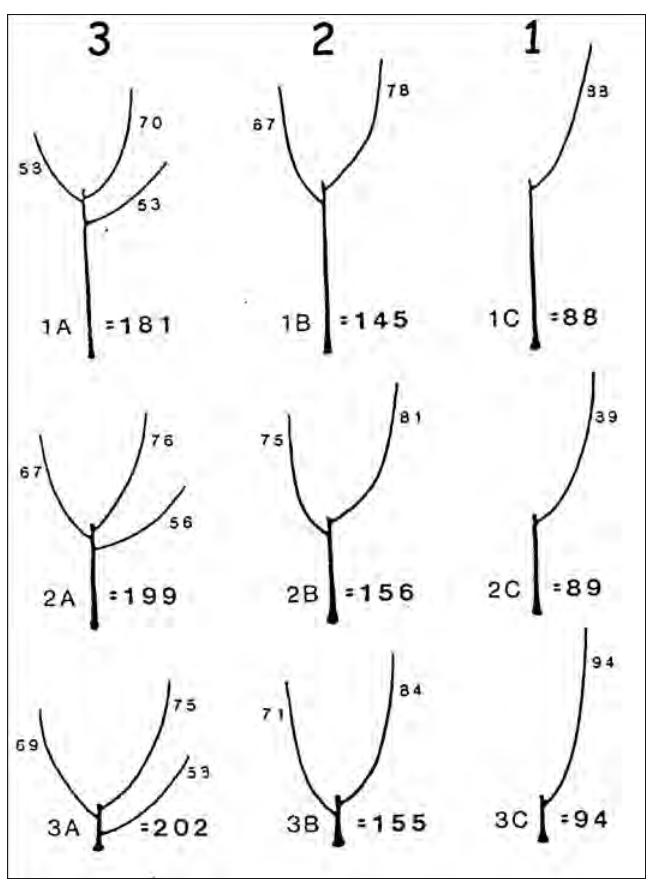
Fig. 12 - Effects of light, medium and severe pruning (one, two, three shoots on a headed-back one-year-old apple tree) (Abbott,